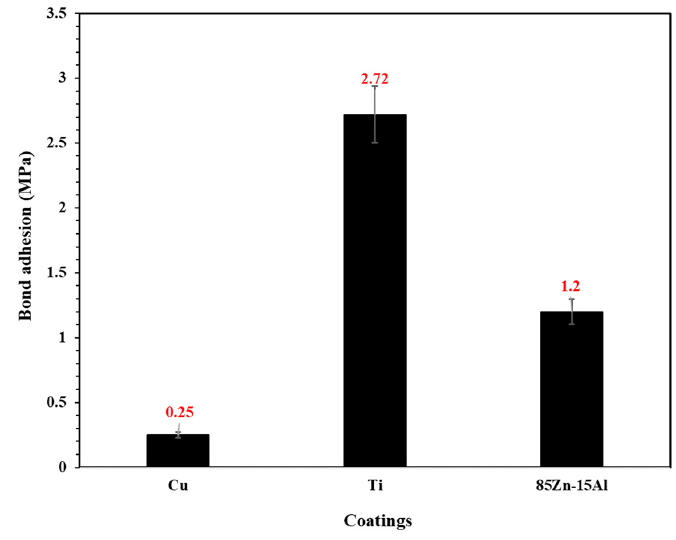
Figure 5. Bond adhesion measurement.